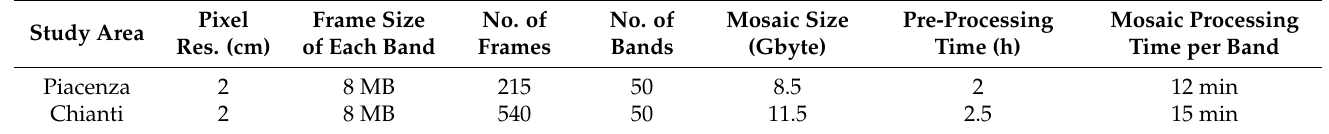
Table 7. Dataset characteristics and processing time of the final hyperspectral ortho mosaics.